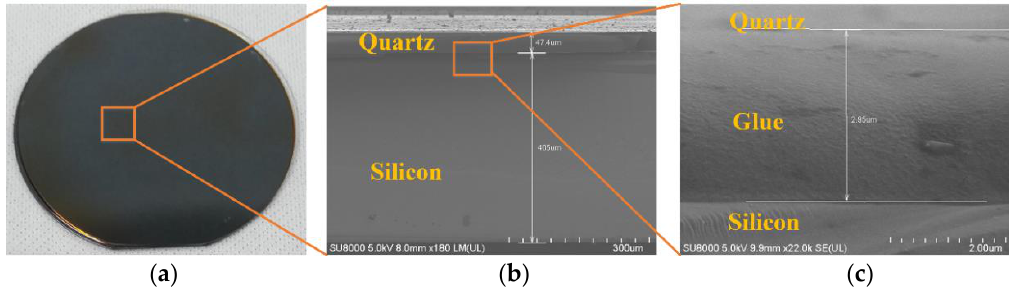
Figure 8. Images of QoS using auxiliary bonding: ( a ) the bonded wafer of quartz and silicon, ( b ) SEM photograph of the cross-sectional view of QoS, and ( c ) partial enlargement view of the SEM photograph.